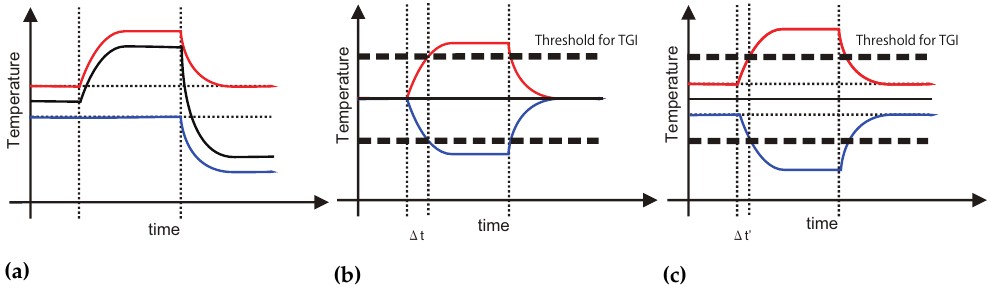
Figure 2. Modelized thermal histories of the conventional and proposed method. ( a ) Thermal history of Sato’s method. The red and blue line shows stimulated temperature on each grid-arrayed Peltier element. The solid black line shows the perceived temperature. The spatially separated pre-warmed or pre-cooled thermal stimulation induces faster recognition of thermal change. ( b ) Thermal history of normal TGI stimulation. The red and blue line shows stimulated temperature on arrayed Peltier elements in a row. The solid black line shows the perceived temperature. The thick dotted line shows the threshold of the pain sensation. ∆ t shows the period until pain sensation. ( c ) Thermal history of the proposed method. The spatially separated pre-warmed and pre-cooled thermal stimulation could induce faster recognition of the pain sensation. ∆ t (cid:48) shows the period until pain sensation.